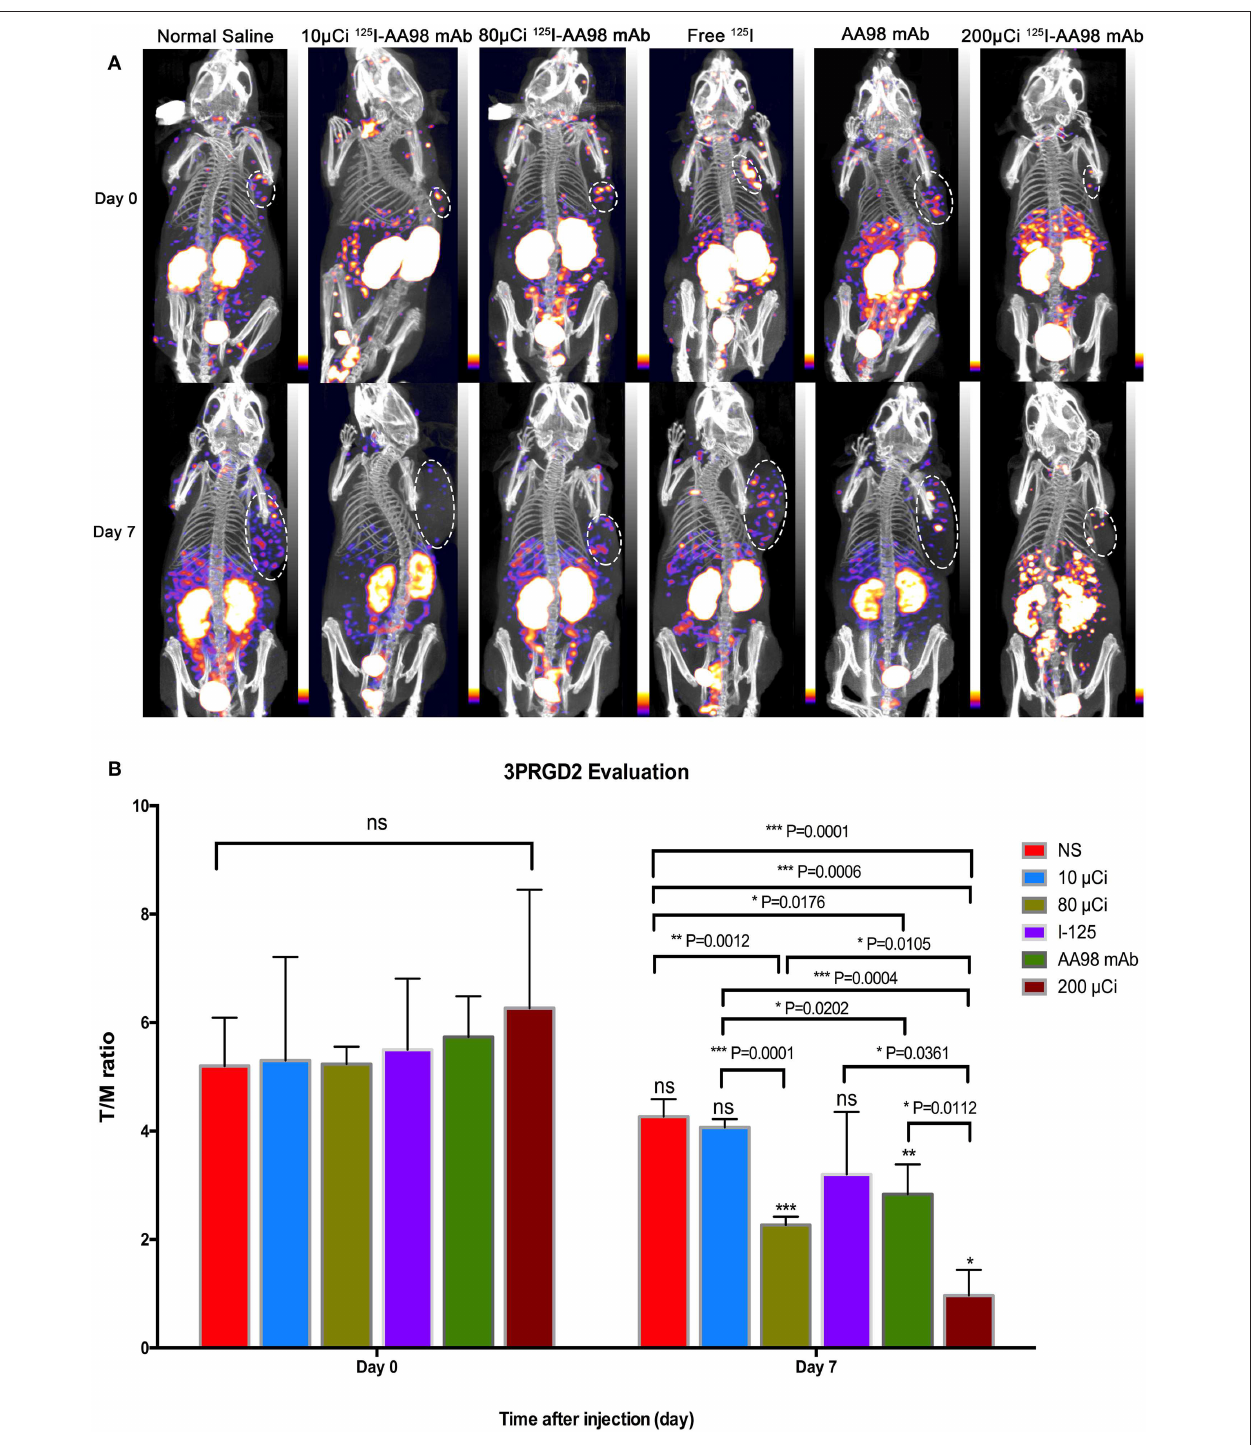
FIGURE 3 | In vivo SPECT/CT imaging with 99m Tc-HYNIC-3PRGD2 and integrin α ν β 3 immunofluorescence staining in HCC xenograft mice models. Tumor images were obtained with SPECT/CT before (upper row) and 7 days after (bottom row) intratumoral injection among the six groups (A) . (B) T/M ratio was analyzed from 99m Tc-HYNIC-3PRGD2 imaging at baseline scan before intratumoral injection and second scan 7 days after intratumoral injection. ( n = 3, mean ± SD, * P < 0.05; ** P < 0.01; *** P < 0.001; ns indicates no significance between the baseline scan on day 0 and the second scan on day 7, P > 0.05; µ Ci means microcurie; white dashed circled area in (A) indicates HCC